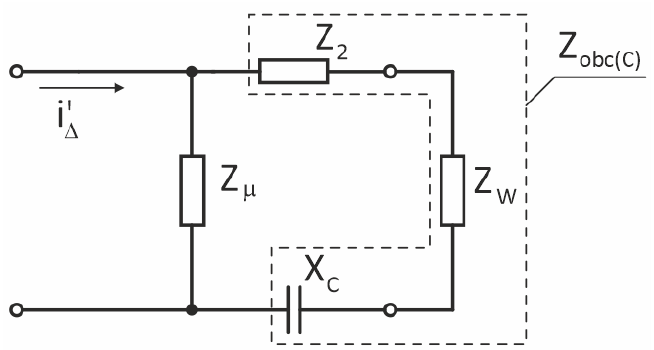
Figure 4. Simplified equivalent diagram of the secondary circuit in the summation transformer which takes into account a series capacitor.